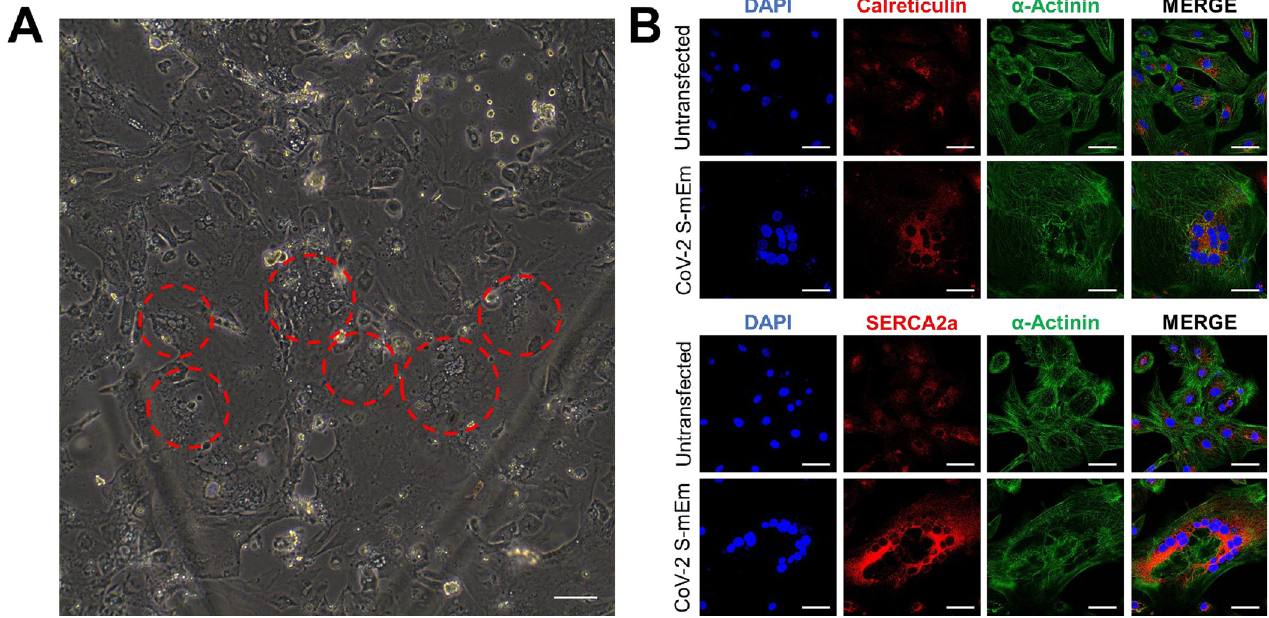
Fig 1. SARS-CoV-2 spike protein induces formation of syncytia in hiPSC-CMs. ( A ) Light microscopy showing hiPSC-CMs following transfection with CoV-2 S-mEm. Red circles indicate clusters of nuclei which represent hiPSC-CM syncytia. Scale bar 400 μ m. ( B ) Confocal immunofluorescence microscopy of both untransfected and CoV-2 S-mEm-transfected hiPSC-CMs displaying the cardiac marker α -Actinin and sarcoplasmic reticulum proteins calreticulin and SERCA2a. Scale bars 50 μ m.